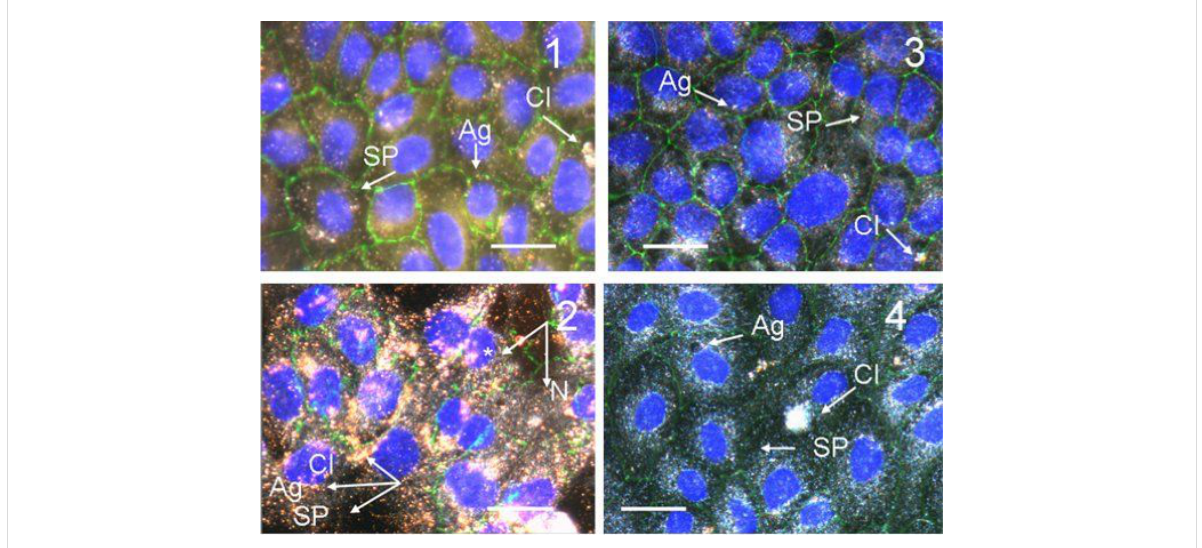
Figure 2: Dark-field/fluorescence microscopy image (overlay) of confluent MDCK II cells treated with gold nanorods after 24 h. Image 1: Cells exposed to 0.14 μ g/mL CTAB coated gold nanorods per mL. Image 2: Cells exposed to 2 μ g/mL CTAB coated gold nanorods per mL. Image 3: Cells exposed to 4.0 μ g/mL COOH-PEG coated gold nanorods per mL. Image 4: Cells exposed to 4.0 μ g/mL NH 2 -PEG coated gold nanorods per mL. The images are overlayed with a fluorescence images using DAPI (nucleus, blue, *) and ZO-1 (cell borders, green) staining. Arrows indicate the particles